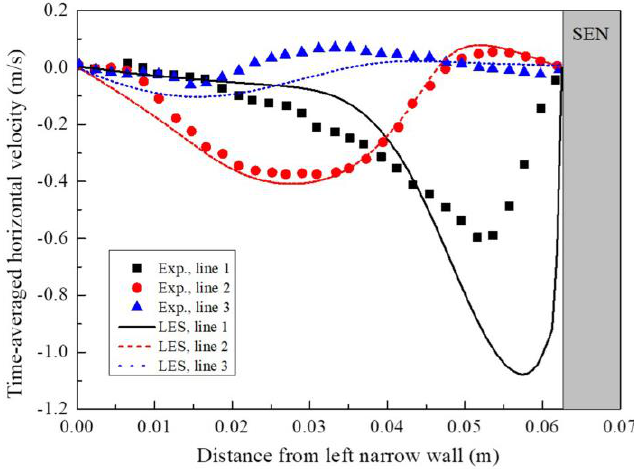
Figure 4. Time-averaged horizontal velocity profiles on three different lines across the mold.